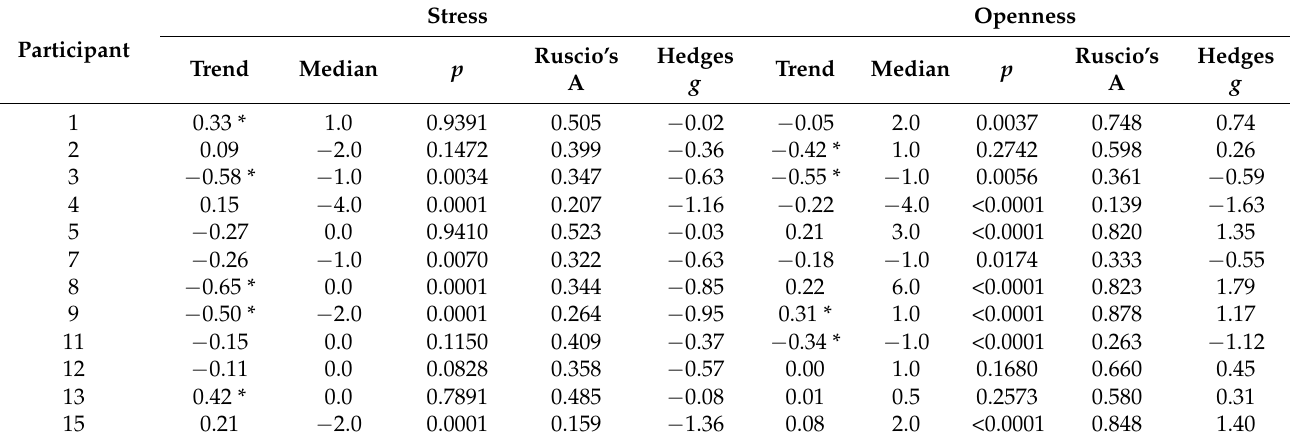
Table 10. Quantitative analyses summaries for stress and openness to